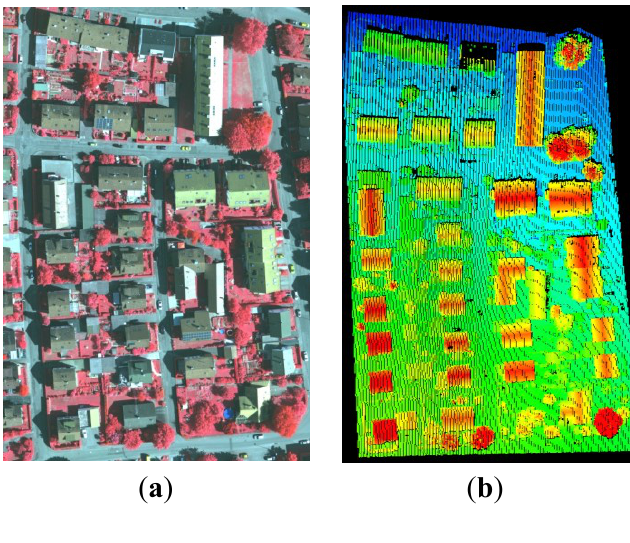
Figure 8. Digital imagery and LiDAR point cloud of the test area. ( a ) Digital CIR aerial image; ( b ) LiDAR point cloud colored according to the height over the test